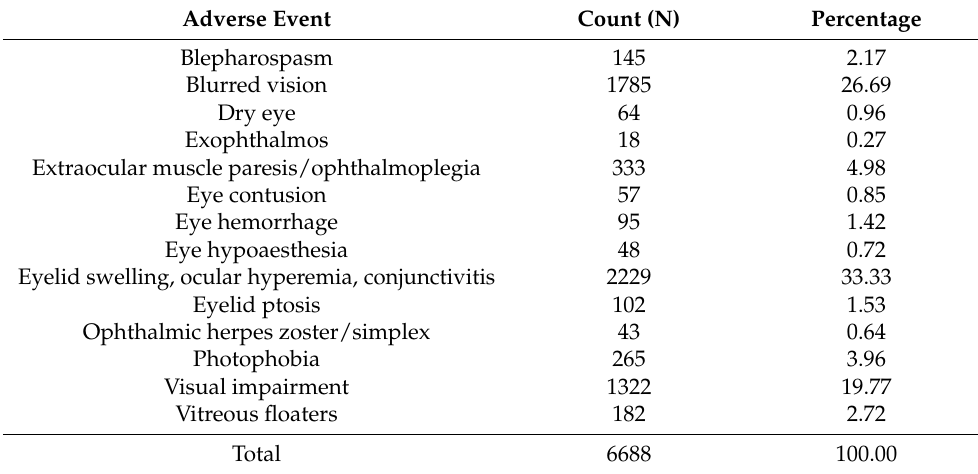
Table 1. Proportion of main adverse events.